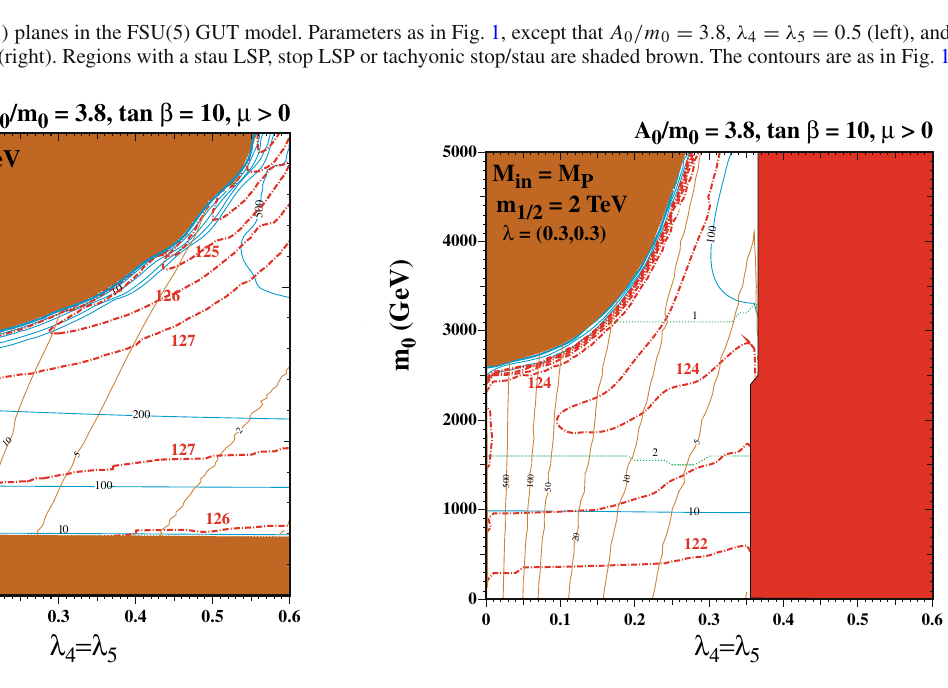
LSP is charged or tachyonic, and the RGEs break down in the red shaded region at large λ 4 = λ 5 in the right panel. The contours are as in Fig.